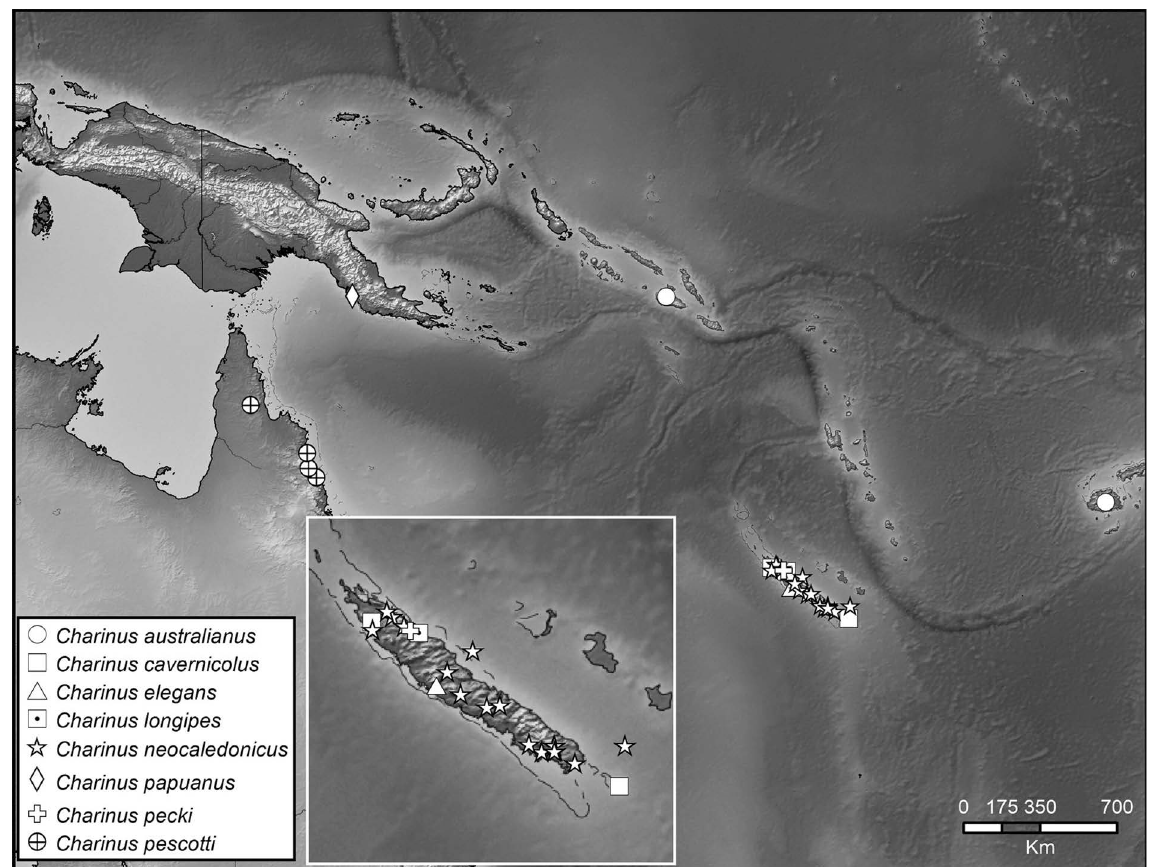
Fig. 94. Map plotting known distributions of species of Charinus Simon, 1892 in Oceania, with inset for New